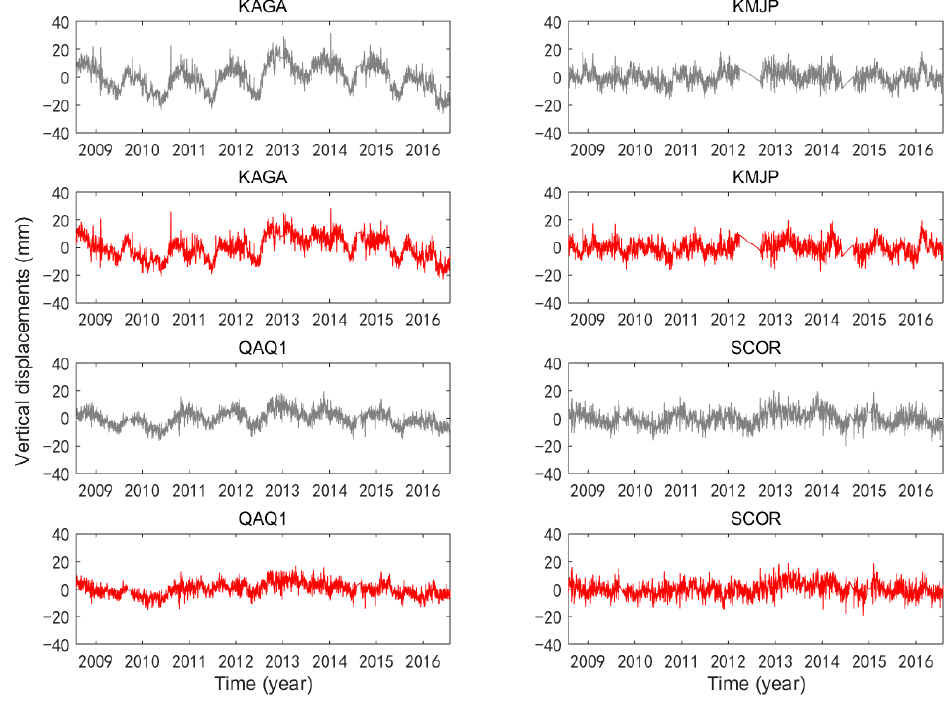
Figure 13. GPS station: detrended vertical time series (gray line), seasonal periodic displacement (red line) corrected by GRACE data.